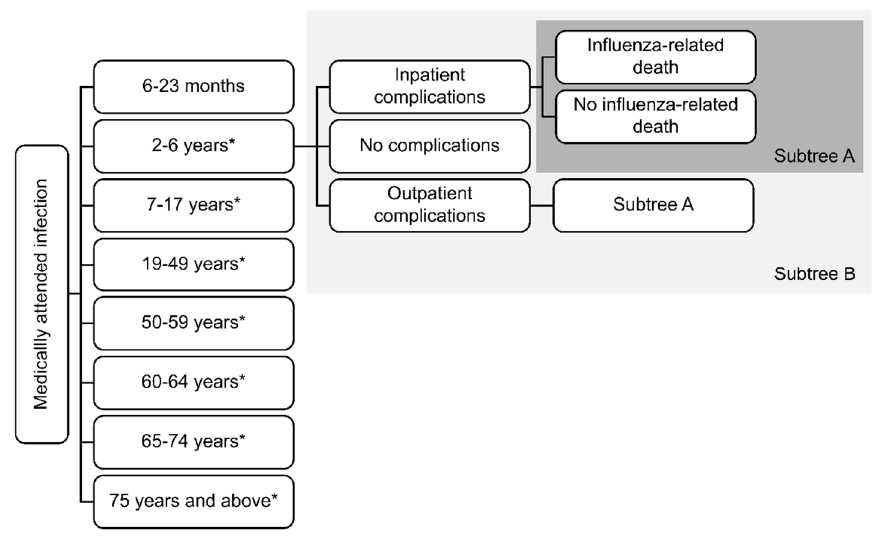
Figure 1. Resource use module structure. * The subtree B structure is repeated for all age groups, but this is not shown in the illustration.